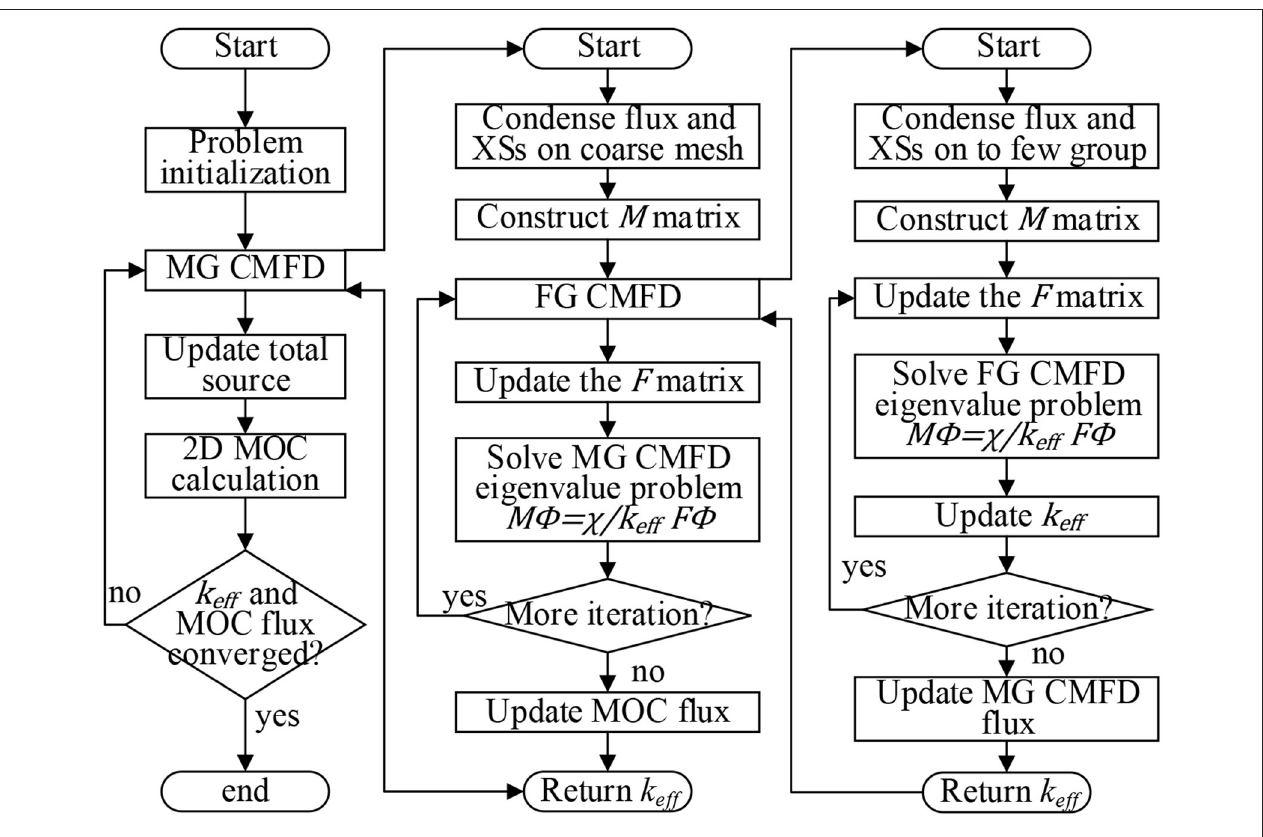
FIGURE 1 | The solution procedure for two-level CMFD accelerated MOC.